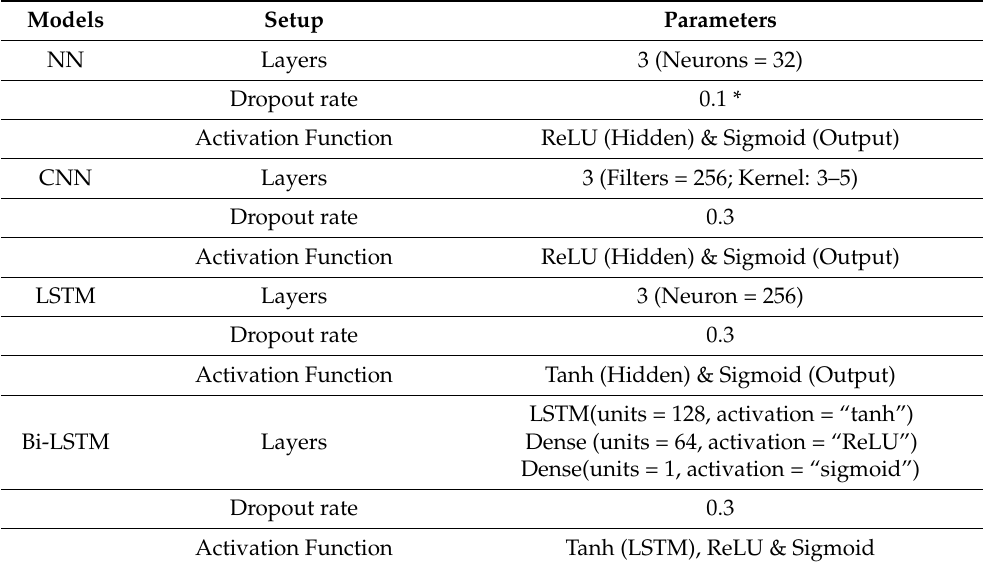
Table 3. Parameter setups for DNN models.